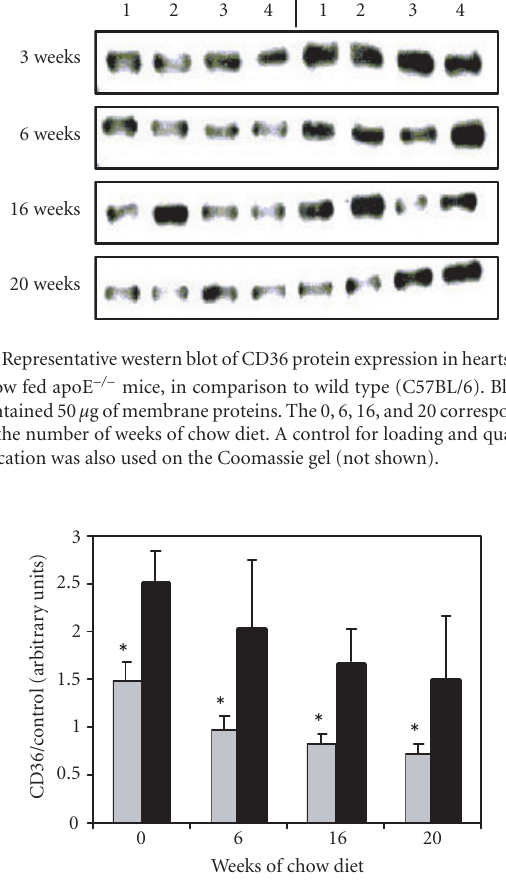
Figure 2. Northern blot analysis of CD36 mRNA levels in the heart. significantly increased ( P < . 05) at 16 weeks compared to the levels observed in wild-type mice (Figures 5a and 5b).